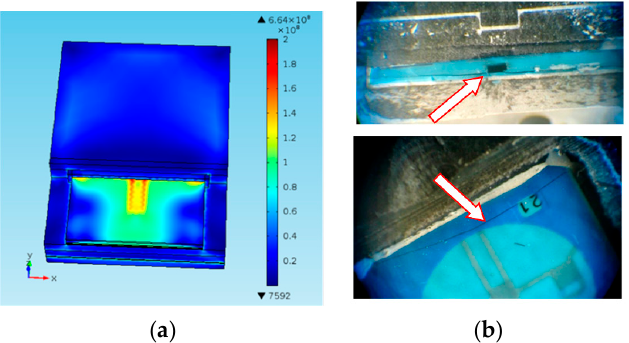
Figure 12. FEA-predicted distribution of the residual von Mises stress in the LTCC sensor after curing and the examples of process induced cracks in the LTCC structure. ( a ) Von Mises stress in the LTCC sensor after curing the epoxy adhesive B at 150 °C. ( b ) The cracks induced in the LTCC structure after gluing in the housing.